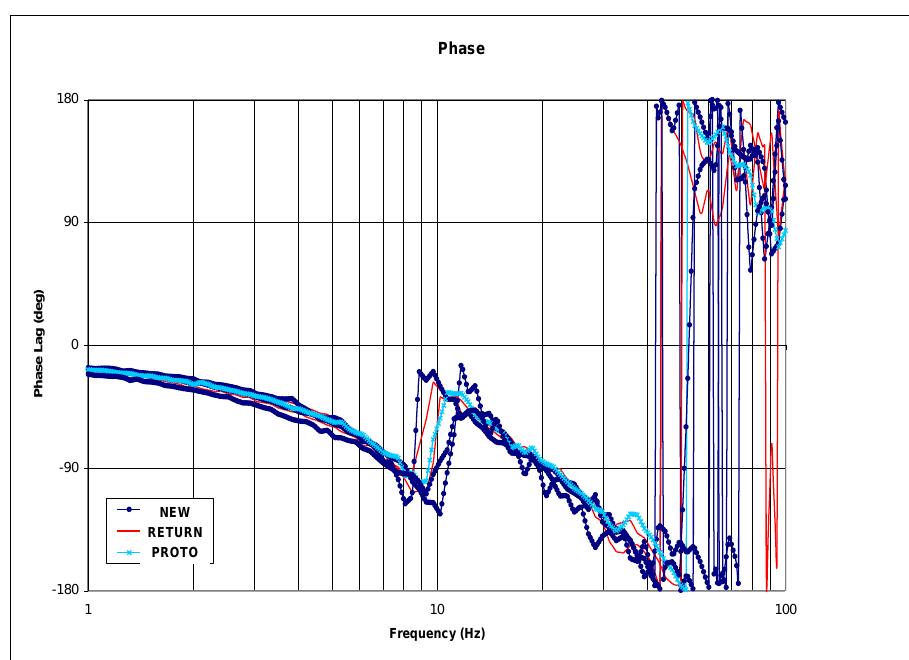
Figure 6. Phase plot of the EFC valves with high